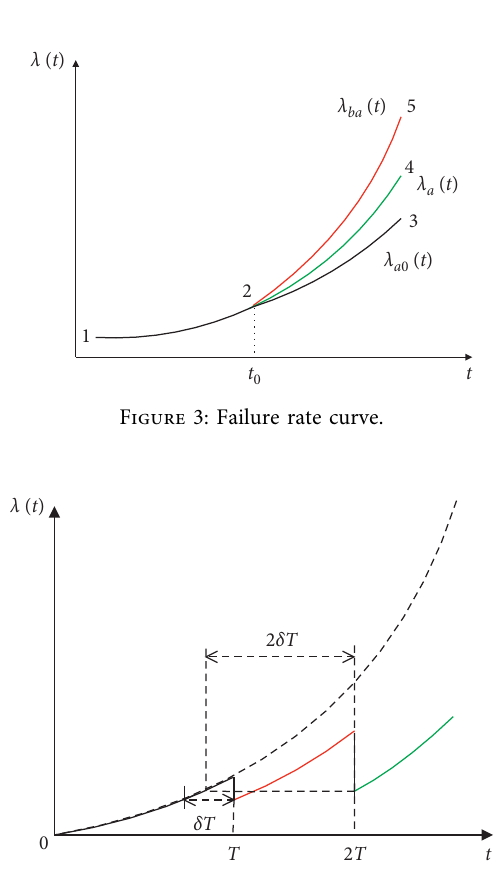
Figure 4: Virtual age method diagram.